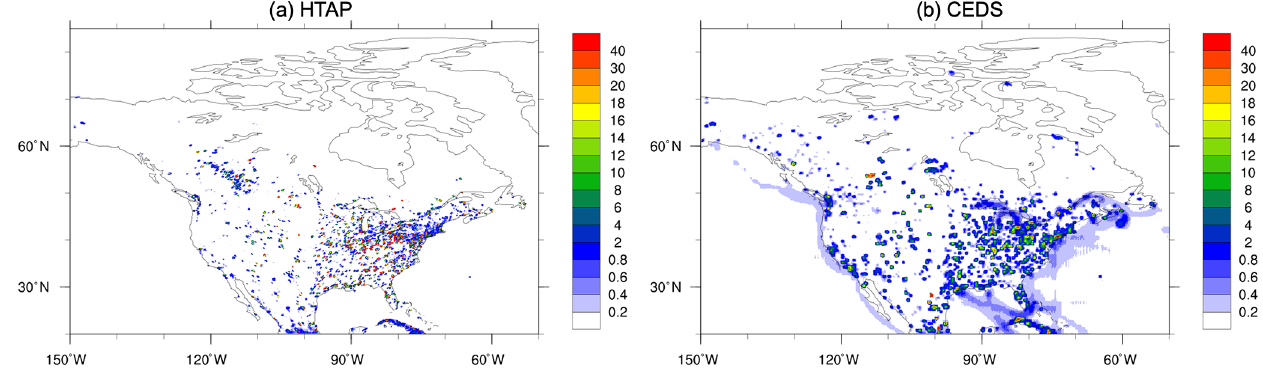
Figure 11. Anthropogenic emissions of SO 2 of (a) HTAP and (b) Community Emissions Data System (CEDS) inventories for August. Unit: molkm − 2 h − 1